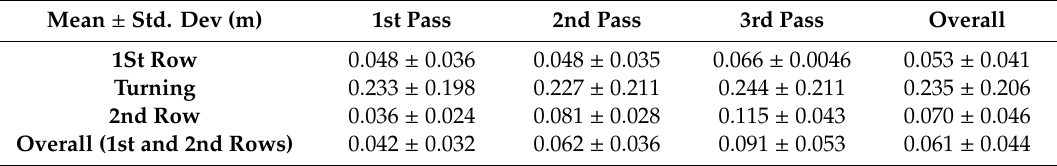
Table 1. The mean absolute error and standard deviations of the three passes along the cotton rows. Mean ± Std. Dev (m)